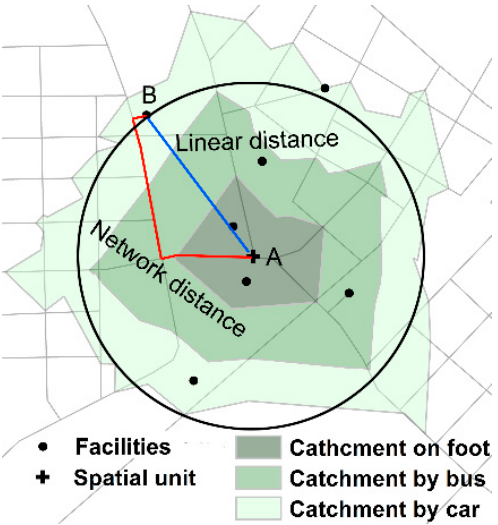
Figure 1. The influence of distance and trip modes on accessibility.